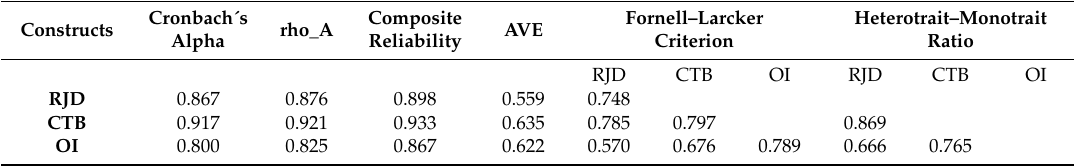
Table 4. Inner model